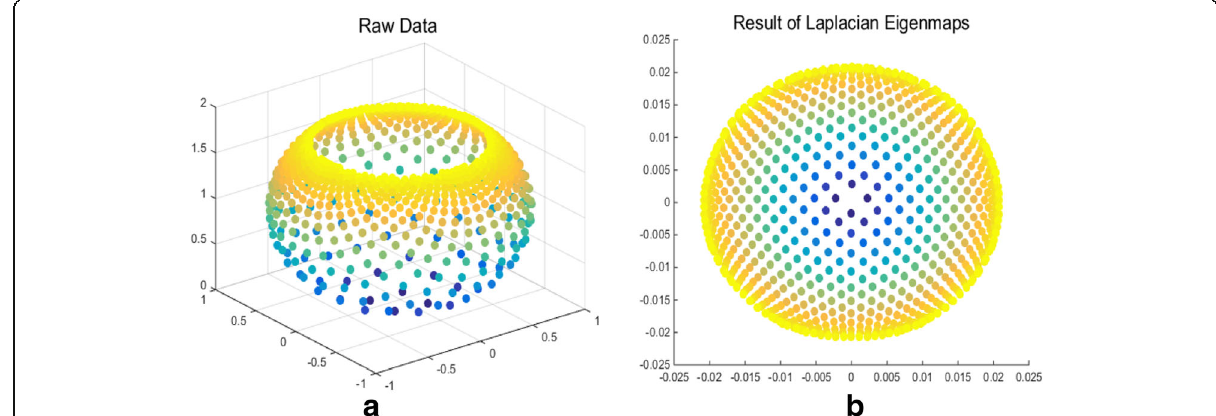
Fig. 1 LE dimension reduction. a The manifold of source data in three dimensions. b Nonlinear mapping in two-dimension space